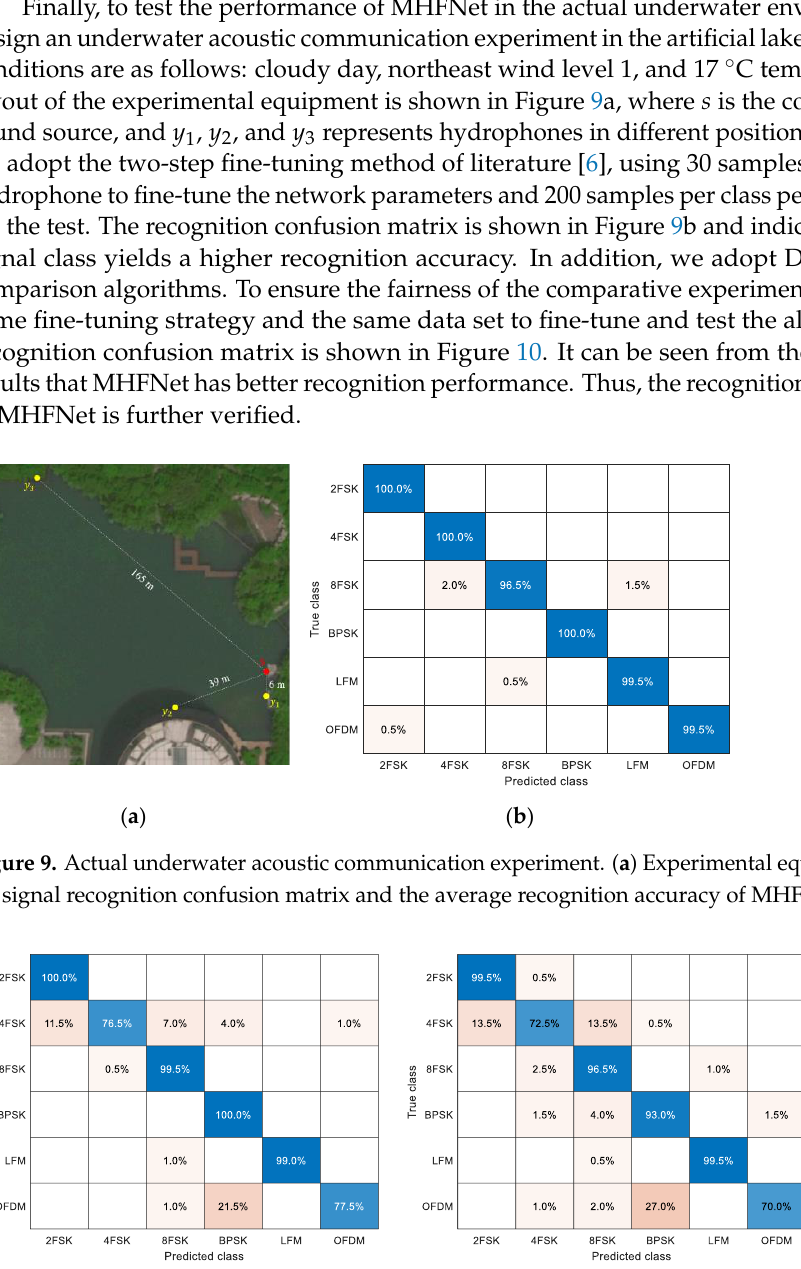
is 92.1%; ( b ) The average recognition accuracy of DV is 88.5%. 92.1%; ( b ) The average recognition accuracy of DV is